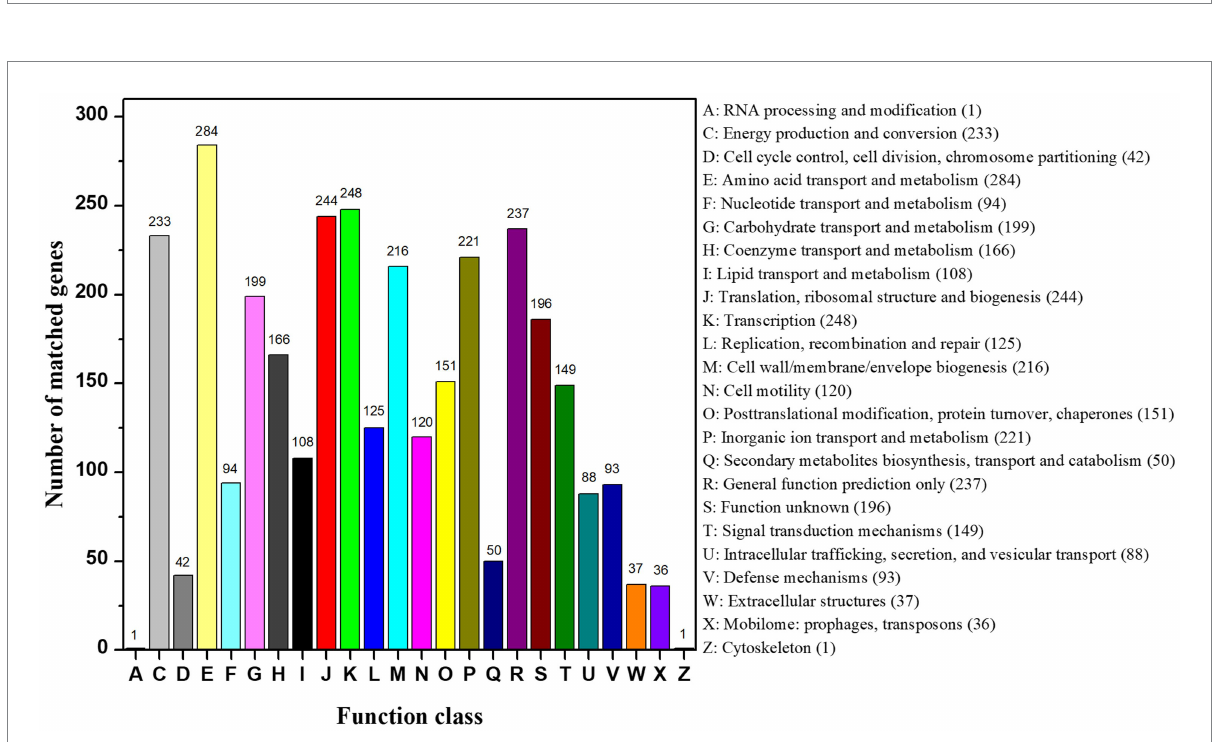
FIGURE 9 COG function classification of CD3